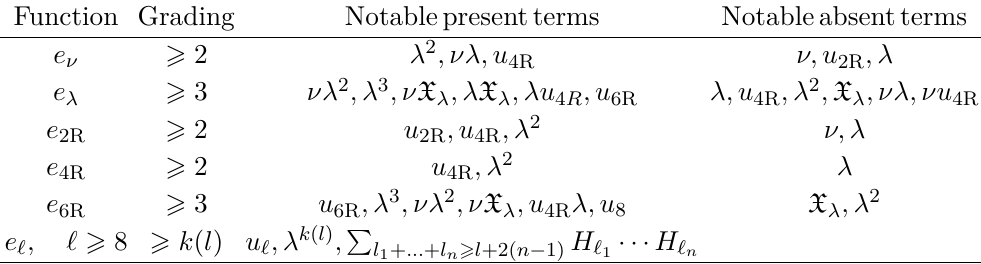
Table 1. Grading of terms in functions e y